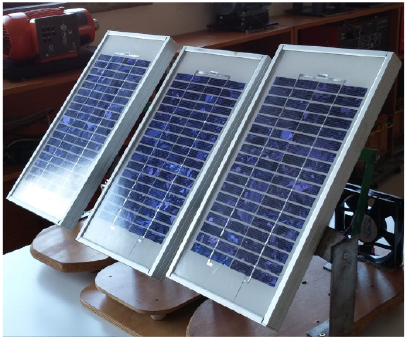
Figure 6. Photograph in which all the trackers of PV panels do not present any fault (no fault).